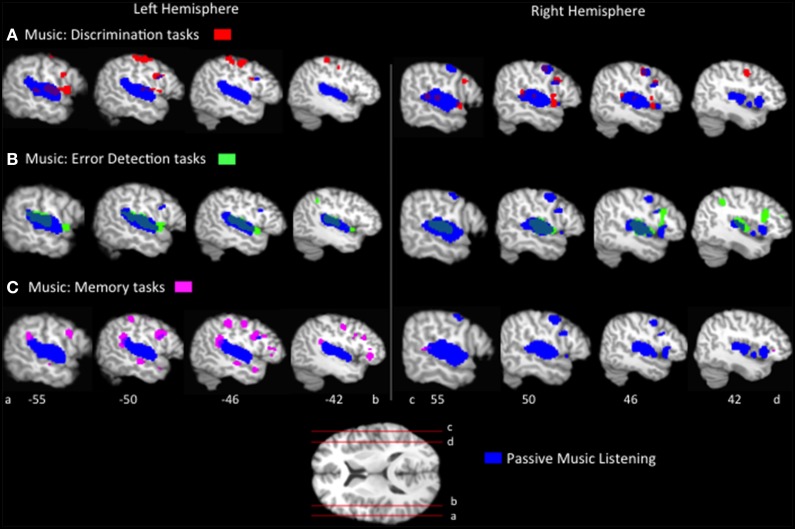
Representative sagittal slices of the ALEs for the (A) music discrimination, (B) music error detection and (C) music memory task conditions, p < 0.05, corrected, overlaid on top of the passive music listening ALE for comparison.